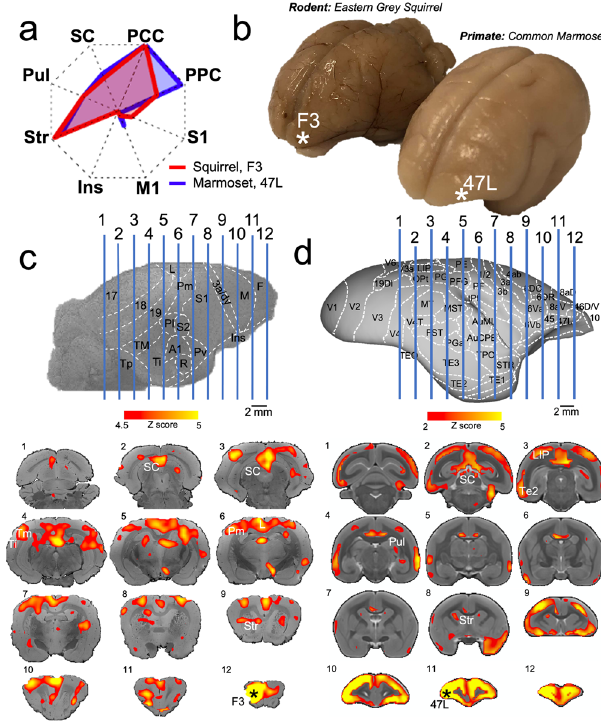
Fig. 4 Similarities in interareal functional connectivity of squirrel region F3 and marmoset area 47L. a Fingerprint for squirrel region F3 and marmoset area 47 L shows a similar interareal functional connectivity pattern. Note that for each species, the fi ngerprints are normalized between 0 and 1 to allow for pattern comparability: A 0 value does not necessarily mean that there was no activation in a region, but just that the region had the lowest relative value within that fi ngerprint. b Photograph of ex vivo squirrel and marmoset brains and the location of squirrel region F3 and marmoset area 47 L. c Anatomically annotated surface rendering and functional connectivity map of squirrel region F3 with the rest of the brain and overlaid on coronal slices of anatomical MR images. d Anatomically annotated surface rendering and functional connectivity map of marmoset area 47 L with the rest of the brain overlaid on coronal MR atlas